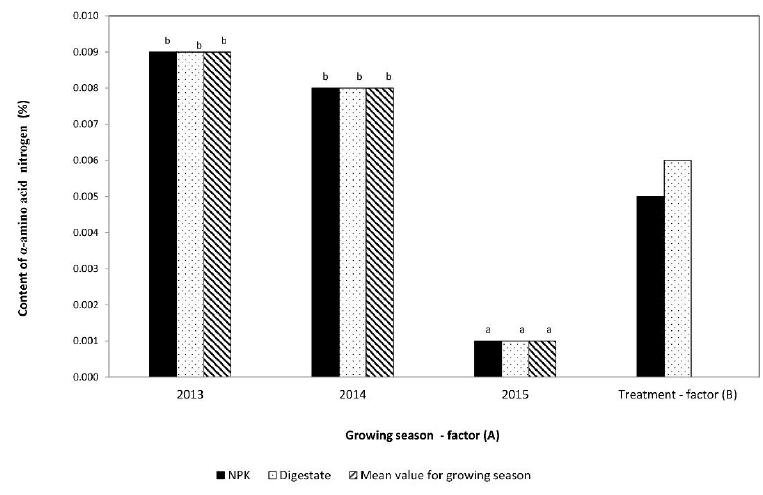
Figure 8. Effects of growing seasons and fertilization treatments on content of α-amino acids nitrogen in sugar beet roots.